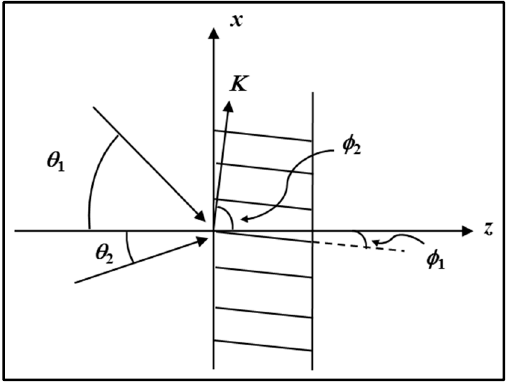
Figure 8. Volume Holographic Grating (VHG) recording set-up, where K is the grating vector (perpendicular to the fringes) and φ 1 is the grating slant angle.